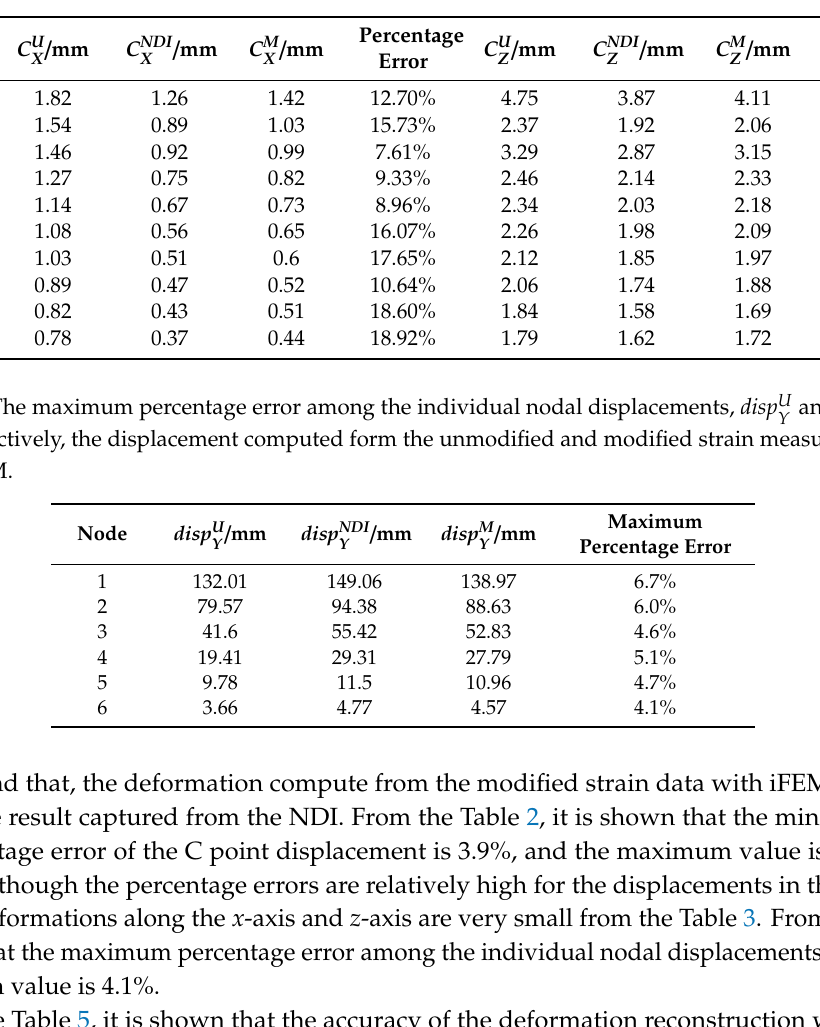
Table 3. Comparison of deformation along the x -axis and z -axis for di ff erent time by removing the load of 20 kg loaded at the wing tip.